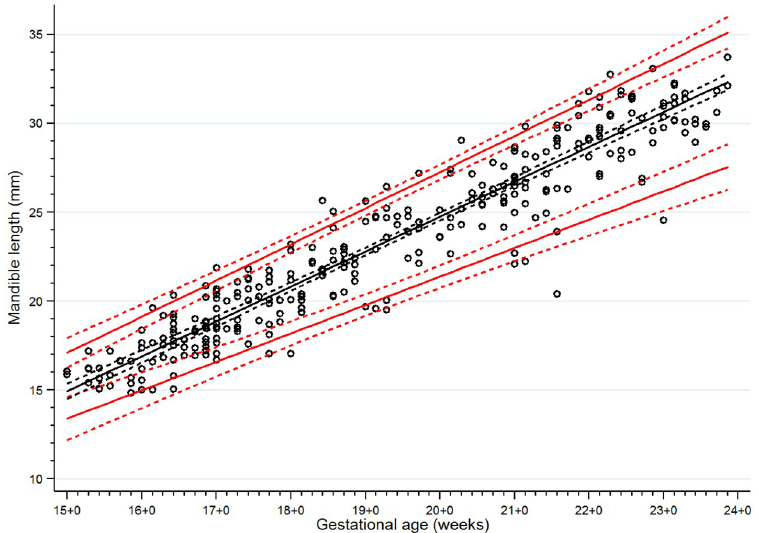
Fig 9. Scatter plot of mandible length (ML) along gestational age. Solid lines represent the ML values in the 5th, 50th and 95th percentiles, Dashed lines represent the 95% confidence interval for each given percentile.